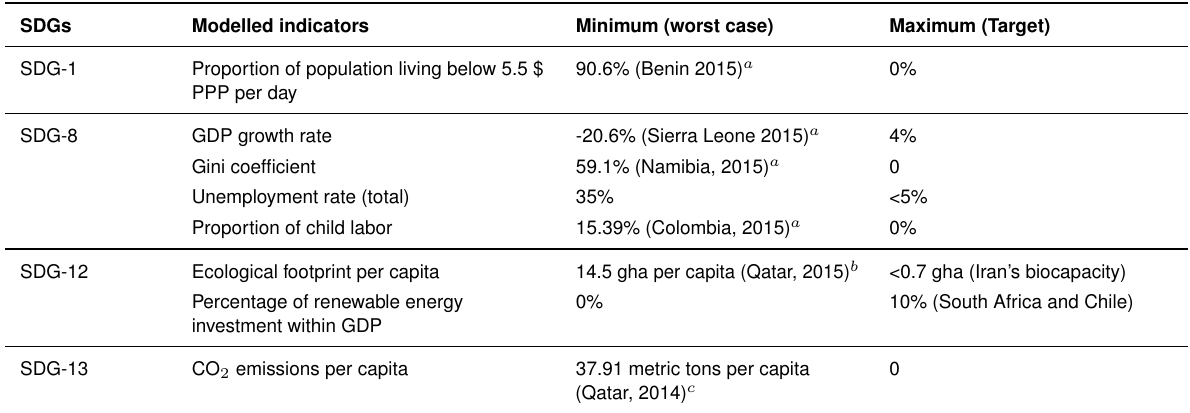
Table 1. Traffic light system for ICS performance from different inspection levels in a group certification scheme. Sources: a World Bank, b Ecological Footprint Network [26], and c Wordometers [38].